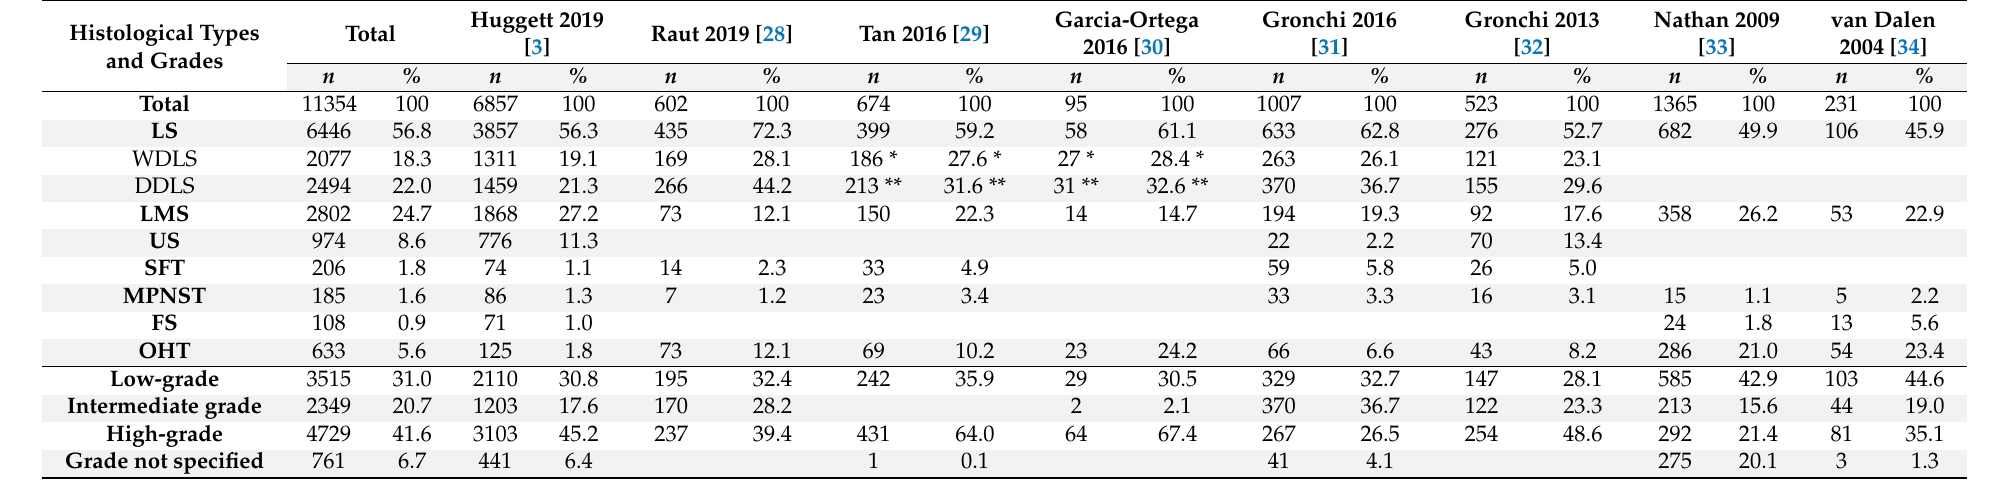
Table 2. Numbers and ratios of the most common retroperitoneal sarcoma histologic types and grades in some recent